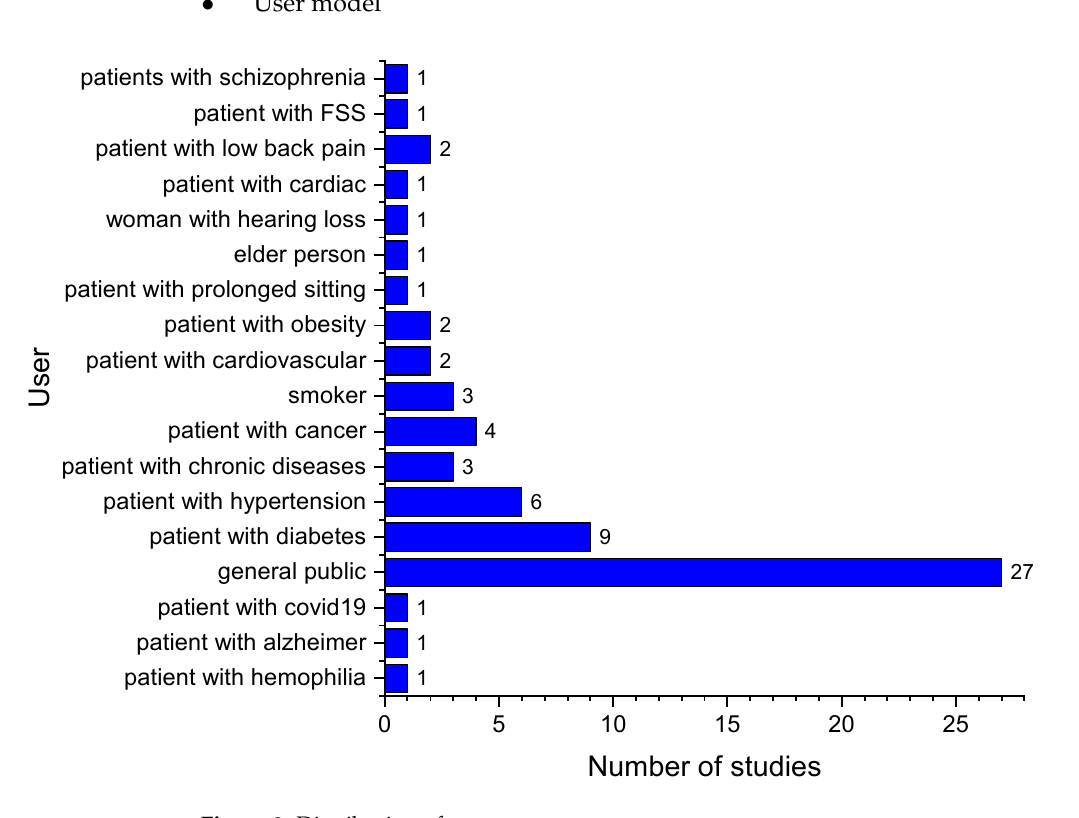
Figure 2. Distribution of target user.